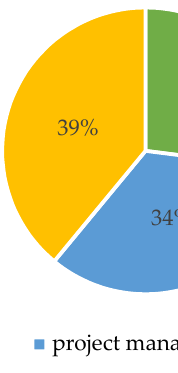
Figure 6. Occupational distribution map of 100 respondents. The scoring results of 100 experts are averaged, as shown in Table 9. Table 9. Expert scoring results table.